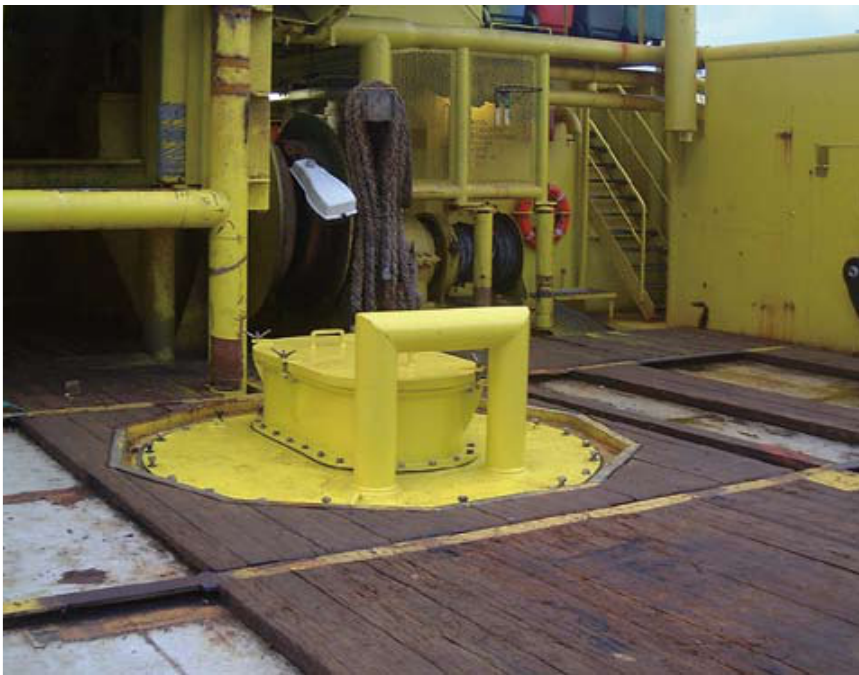
Figure 4. The moonpool returned to a chainlocker at the end of